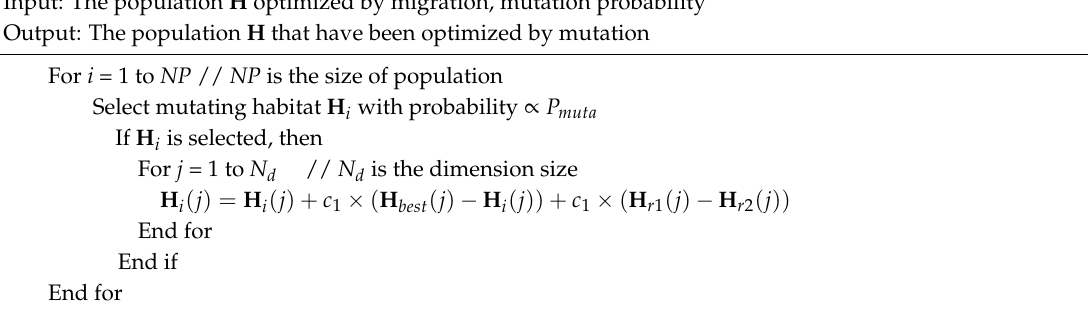
Algorithm 2: Mutation for the MDP (Mutation Do(H, P muta